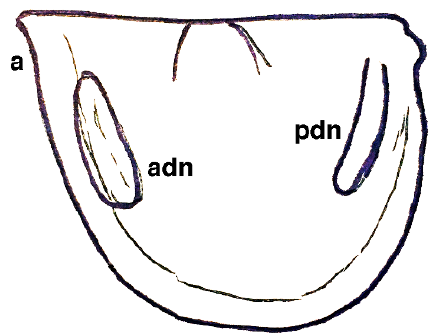
Figure 8. Bicarinellata evansi . Anterior to left. Letter “a” denotes anterodorsal cardinal corner marginal concavity. Length of shield 1.5 mm. Abbreviations: a, anterodorsal cardinal marginal concavity; adn , anterodorsal node; pdn , posterodorsal node. Image Credit: Mark McMenamin.